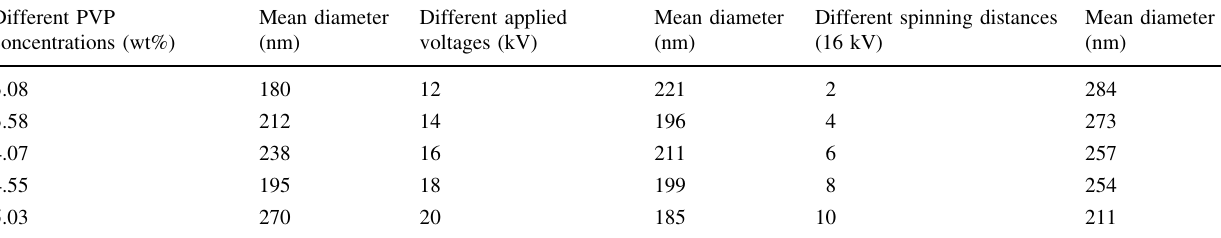
Table 5 Different diameters of PbI 2 /PVP composite fibers obtained at different PVP concentrations, different applied voltages, and different spinning distances Different PVP concentrations